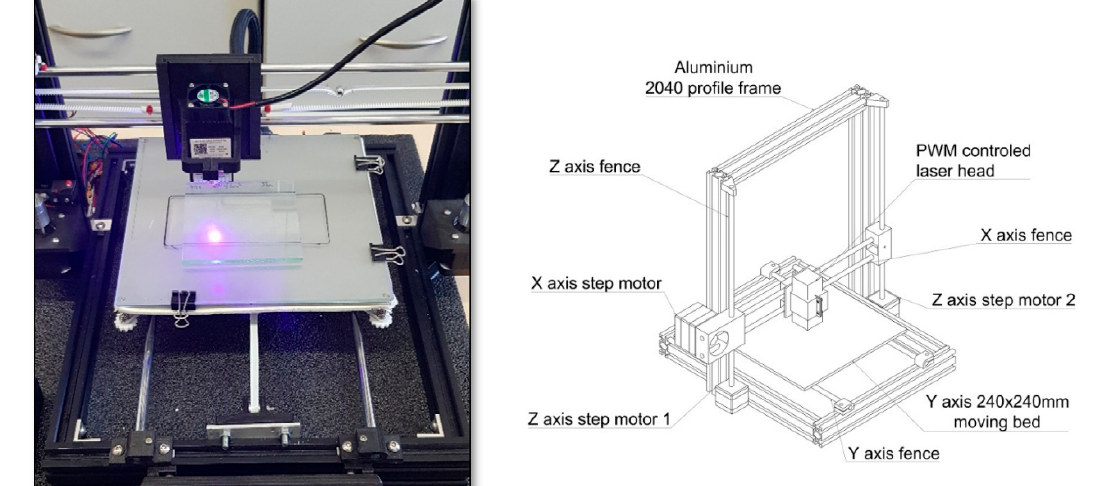
Figure 22. Home-made Computerized Numerical Control (CNC) machine with a 405 nm laser diode with continuous beam and fully adjustable laser power (constructed by P.Fiedor).